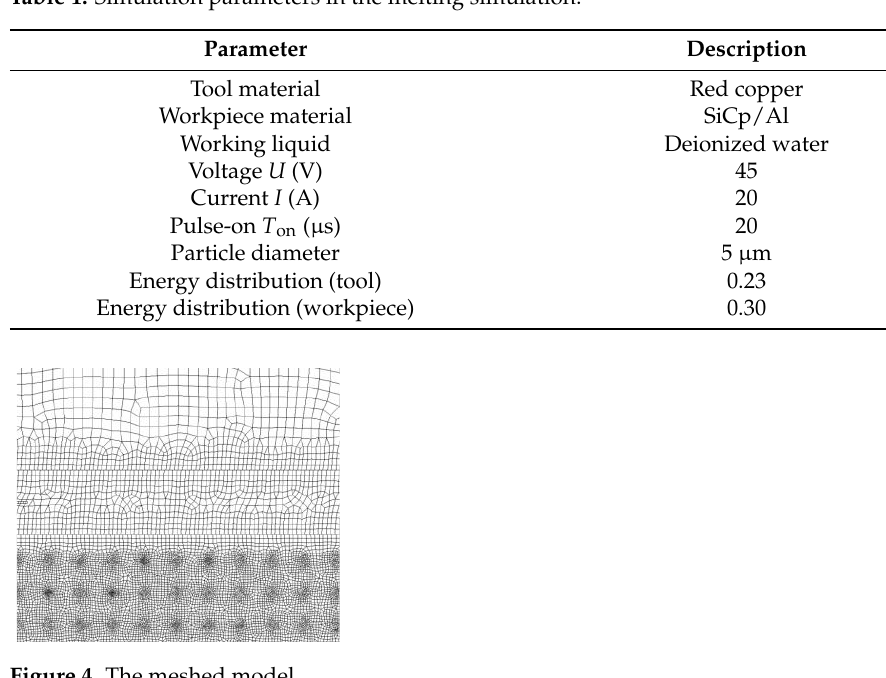
Figure 3. The boundary conditions in the melting simulation model. Table 1. Simulation parameters in the melting simulation.